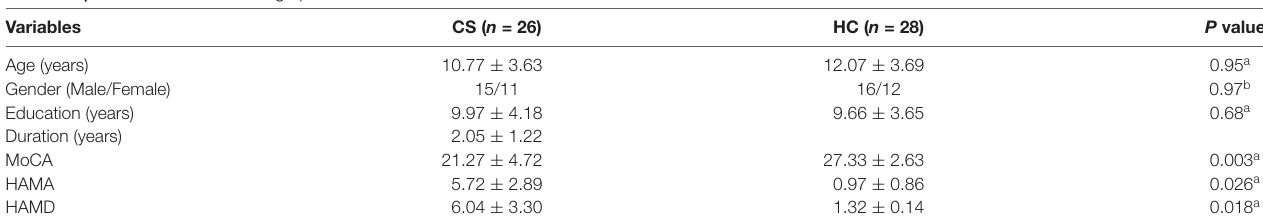
TABLE 1 | Characteristics of demographic and clinical variables.